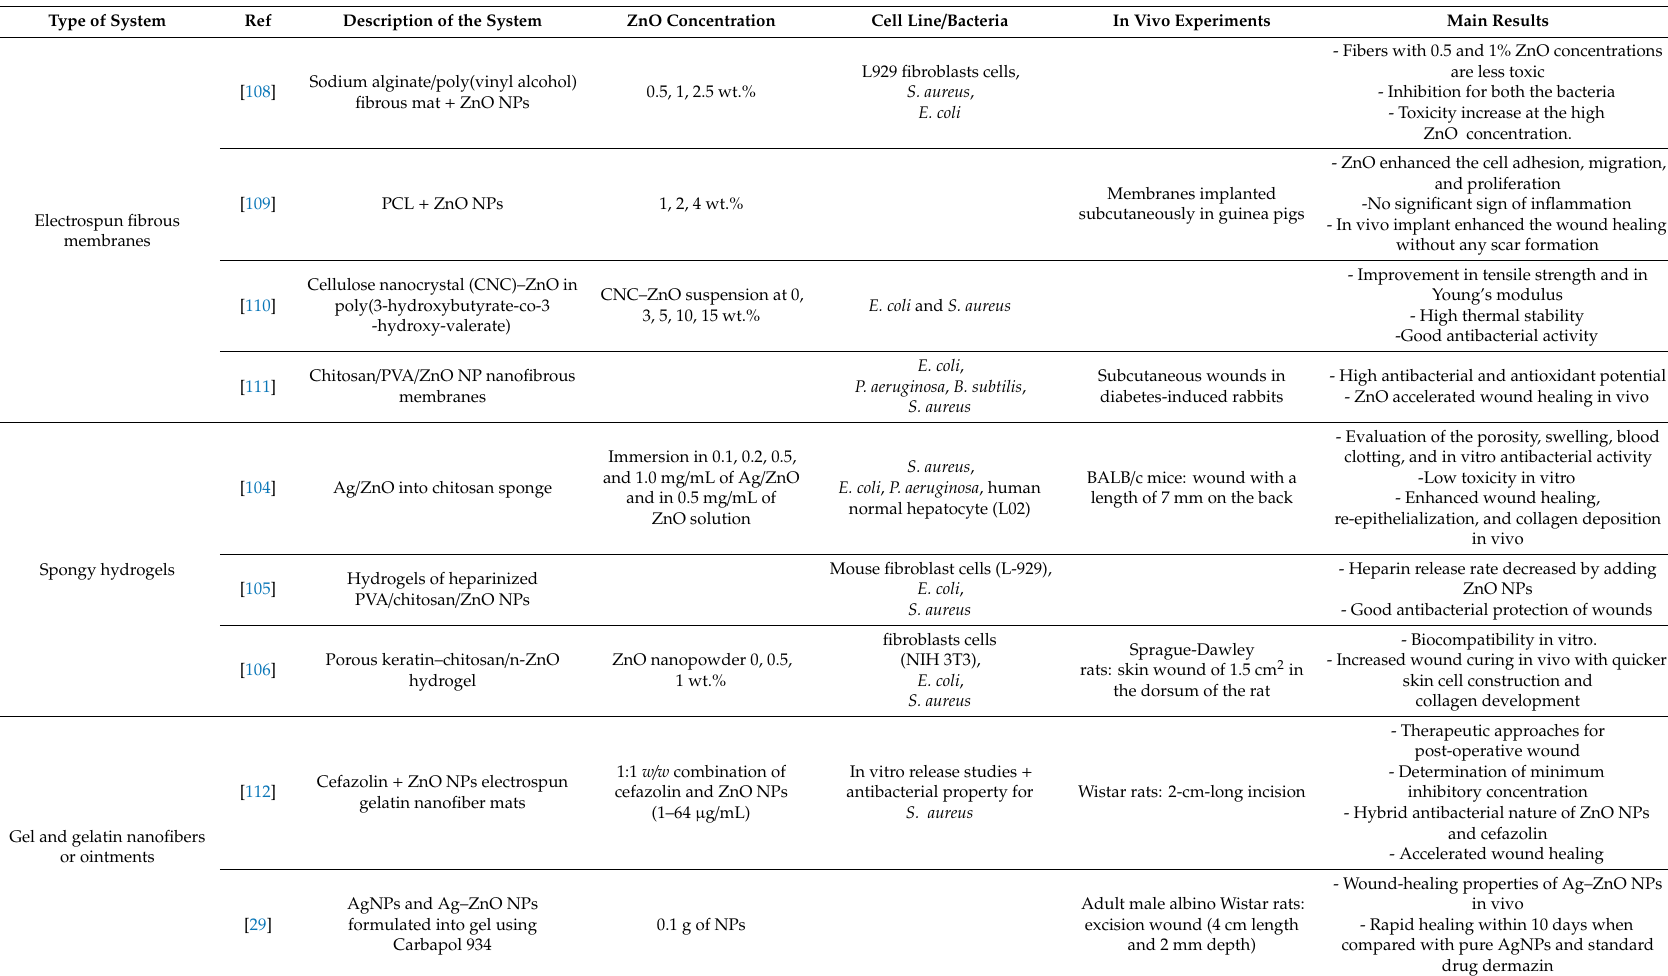
Table 3. Main results of recent studies on ZnO-based nanomaterials and electrospun ZnO–polymeric hybrid nanomaterials for wound-healing applications. Type of